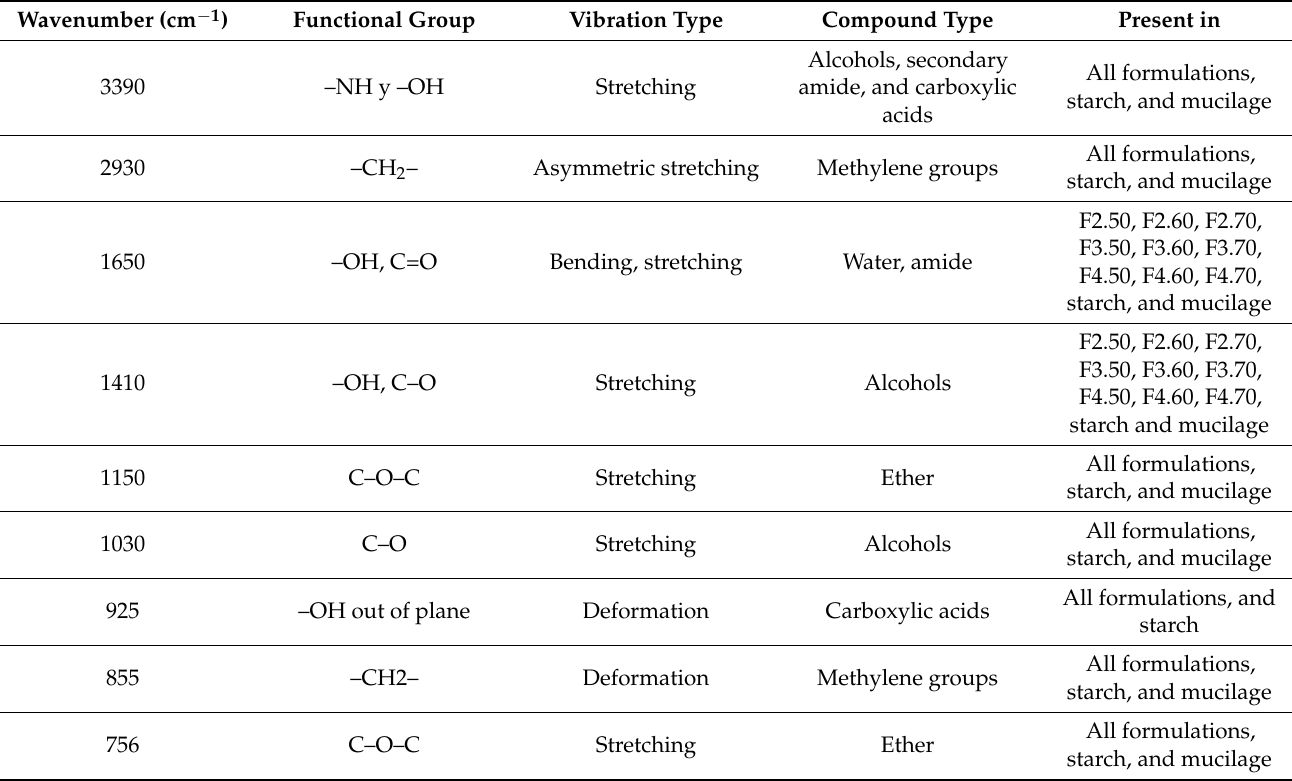
Table 5. FTIR spectra for formulations of edible films, starch, and